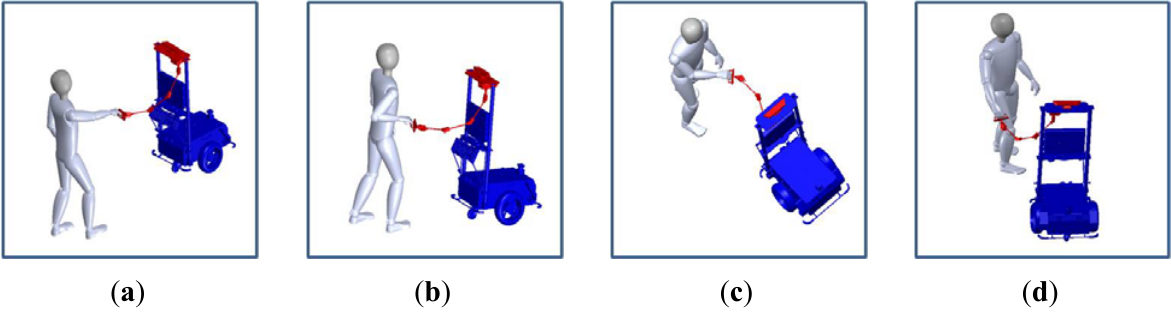
Figure 5. Control motions. ( a ) Speed Increase; ( b ) Speed Decrease; ( c ) Left turn; and ( d ) Right turn.